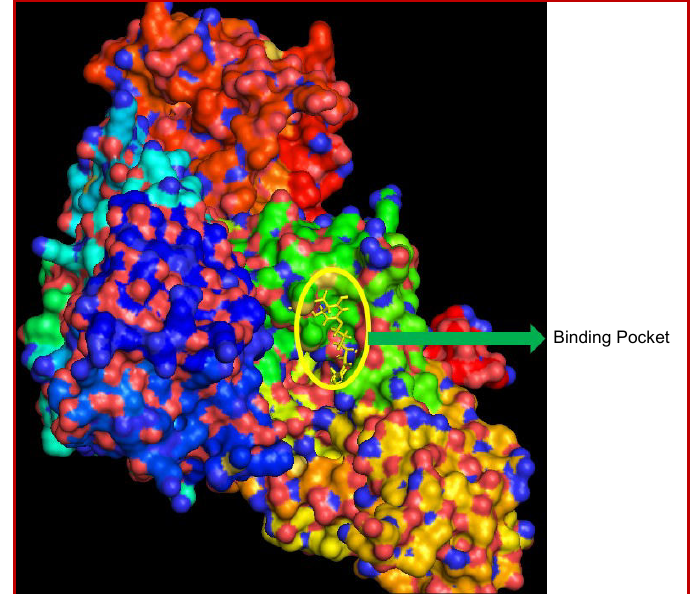
Figure 3: The surface view of the protein with the ligand (XM7) binding